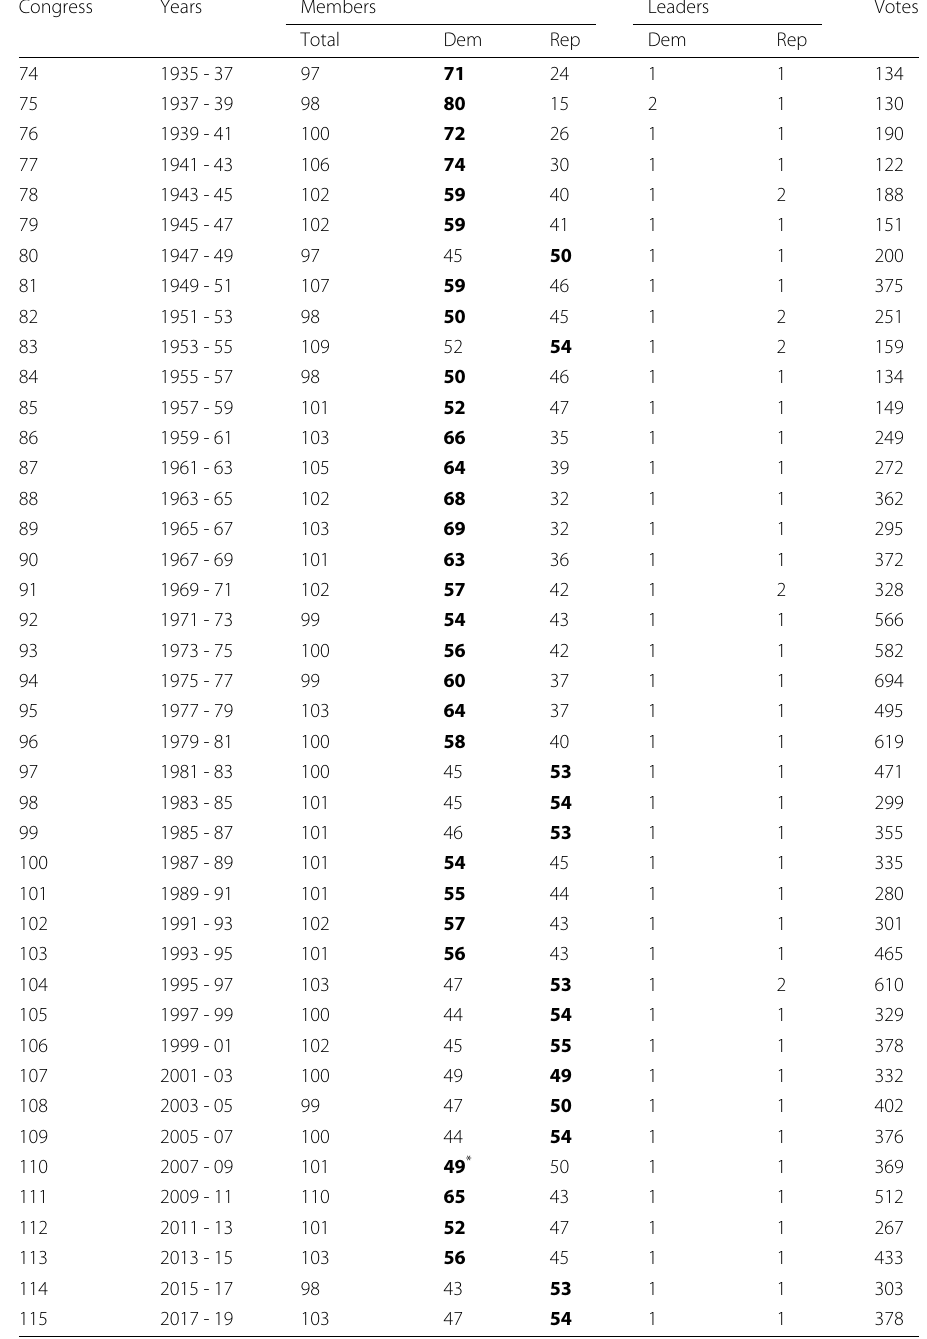
Table 2 Years covered, total number of members (nodes), number of Democrats (excluding leaders), number of Republicans (excluding leaders), number of Democrat leaders, number of Republican leaders, and number of roll call votes for each